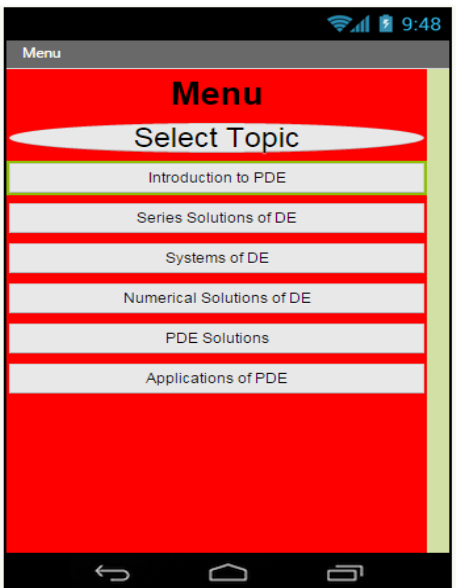
Fig. 3. Menu screen after adding the main